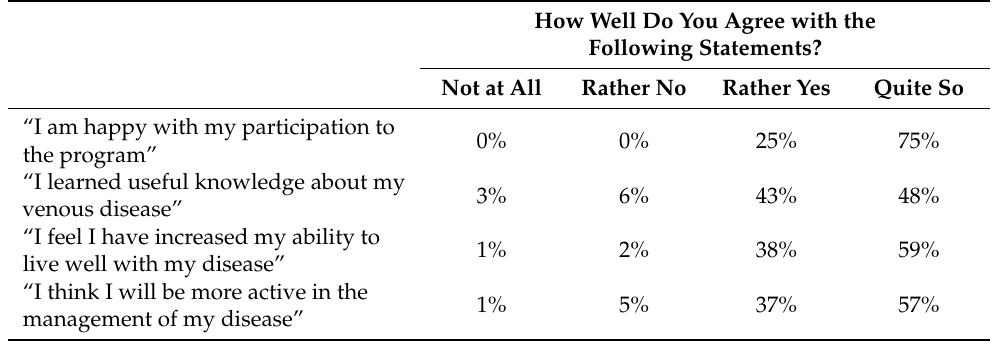
Table 2. Patients’ perception regarding the education program at day 18 (149 answers–1 dropout).